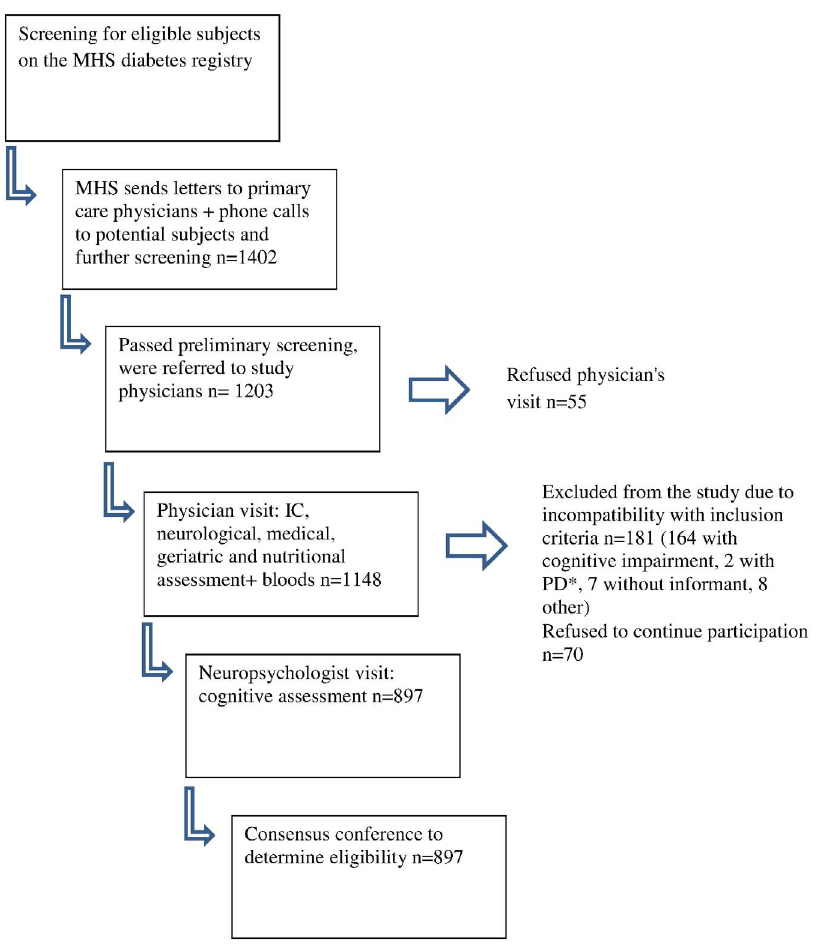
Figure 1. Trajectories in HbA1c levels. Groups: 1=lower Stable, 2=Higher Stable, 3=Lower Increasing, 4=Higher Increasing, 5=Lower Decreasing, 6=Higher Decreasing.